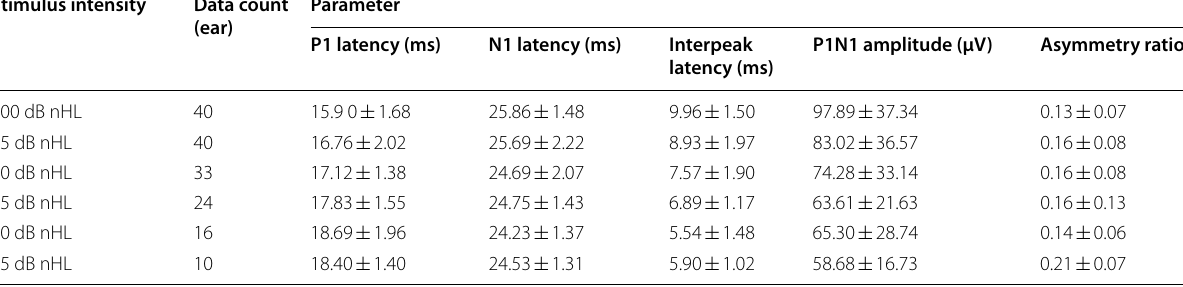
Table 1 Descriptive statistical data of mVEMP measurements Stimulus intensity Data count